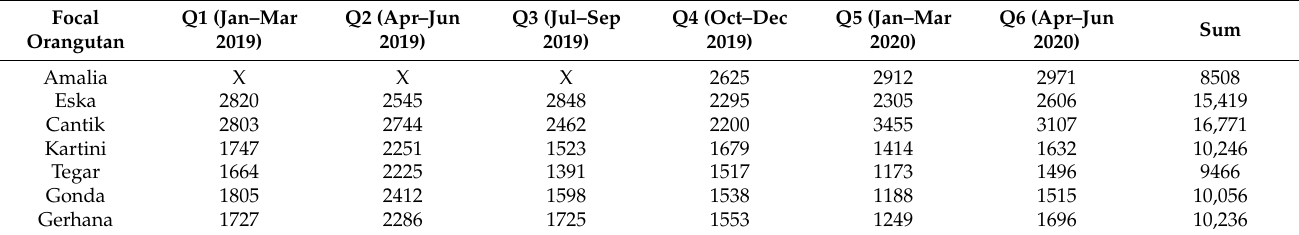
Table 2. Total number of scans per orangutan per period and over all periods (sum). Focal